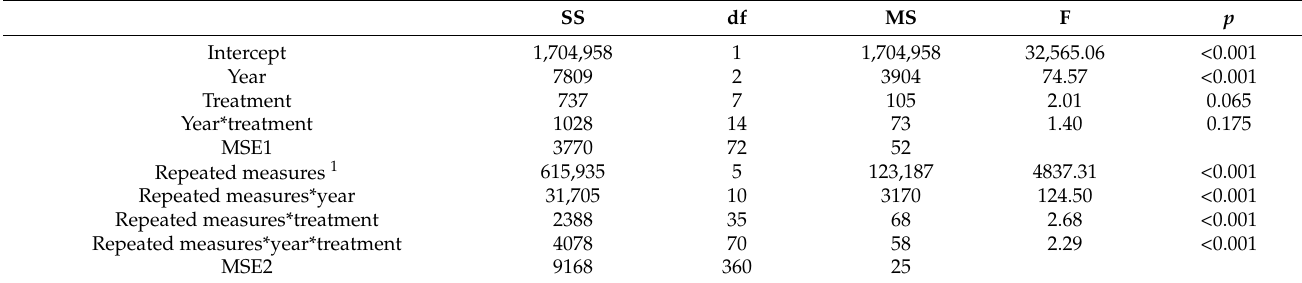
Table 6. Effects based on general linear model which include effect of repeated